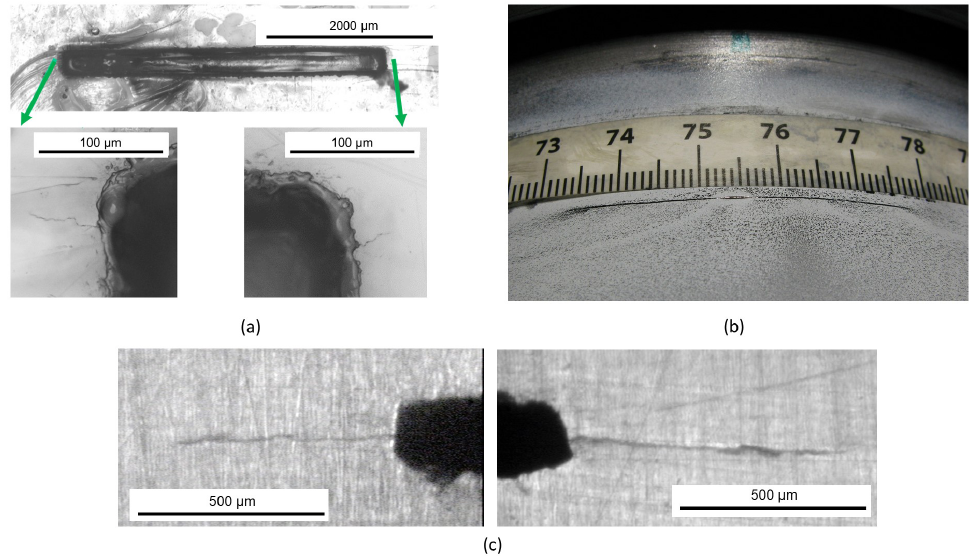
Figure 2. Crack propagation monitoring techniques adopted in the present study: ( a ) the plastic replica method, ( b ) the magnetic particle inspection method, and ( c ) the images captured by means of optical microscope.